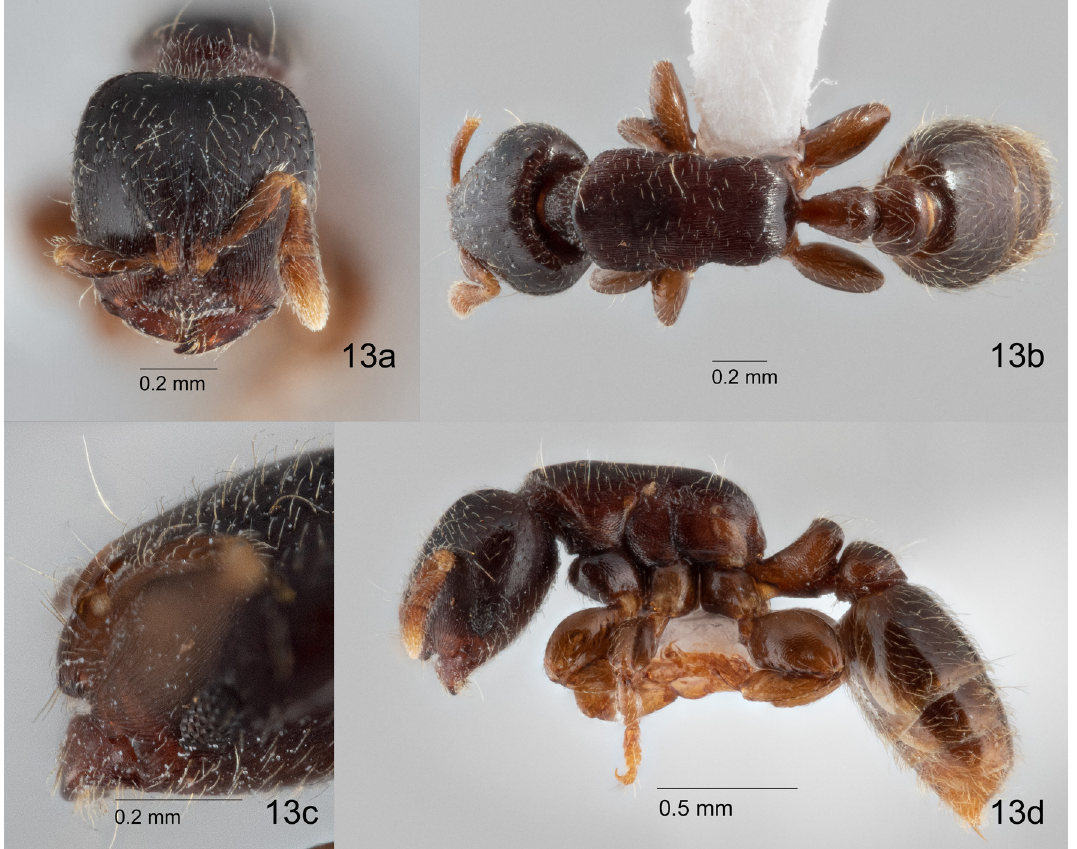
Fig. 13. Rhopalomastix robusta Wang & Jaitrong sp. nov., paratype, average-sized worker (ZRC_ ENT00013949). a . Head in full-face view. b . Body in dorsal view. c . Close-up of clypeus in profile. d . Body in lateral